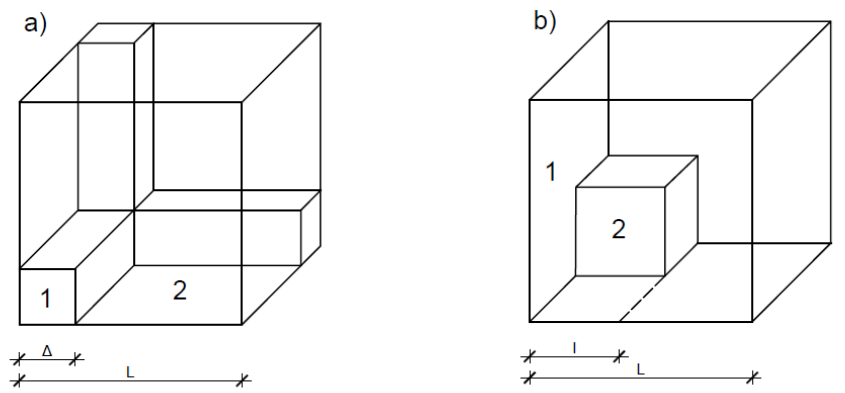
Figure 1. The eighth part of a cubic unit cell: ( a ) structure with two continuous, interpenetrating components (1 and 2); ( b ) structure with continuous component (1) and isolated cubic inclusions (2).